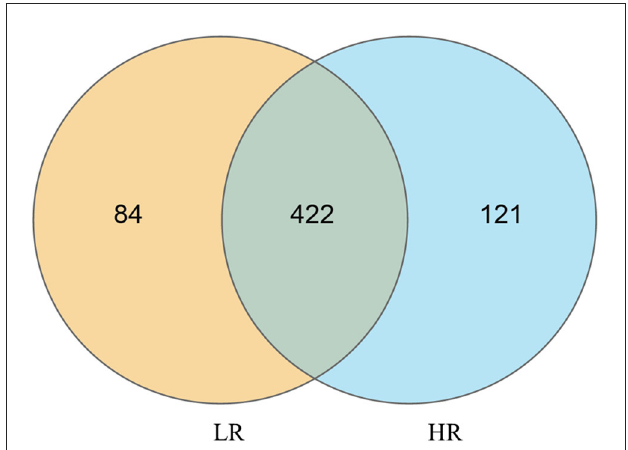
FIGURE1 Quantitative analysis of the differential OTUs between low- and high-residual feed intake small-sized meat ducks.